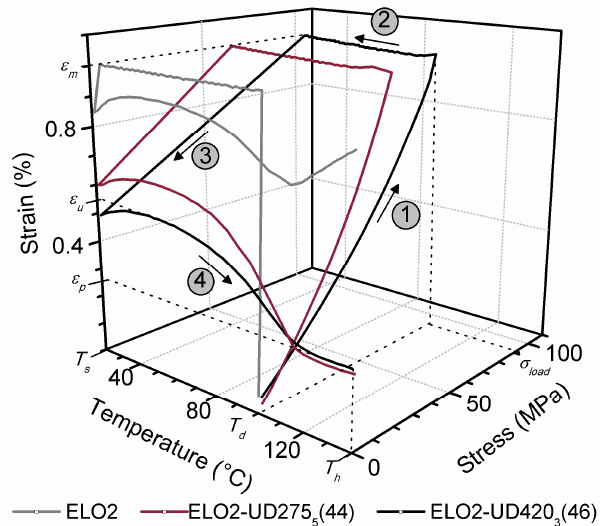
Figure 6. 3D representation of the shape memory behaviour of the epoxidized linseed oil-based bioresin (ELO2, T g ≈ 90 °C) and its UD-flax reinforced composites. Designation: the numbers indicate the steps of shape memory test: ( 1 ) deforming at T = 100 °C to ε m = 1%, ( 2 ) shape fixing by cooling to T = 20 °C while keeping ε m = 1%, ( 3 ) unloading, ( 4 ) stress-free shape recovery. Notes: UD-reinforcements had different surface weights (275 and 420 g/m 2 , respectively, due to fine and coarse flax yarns) but their overall content (44 and 46 wt %) was comparable owing to the number of layers (5 and 3, respectively) built-in.